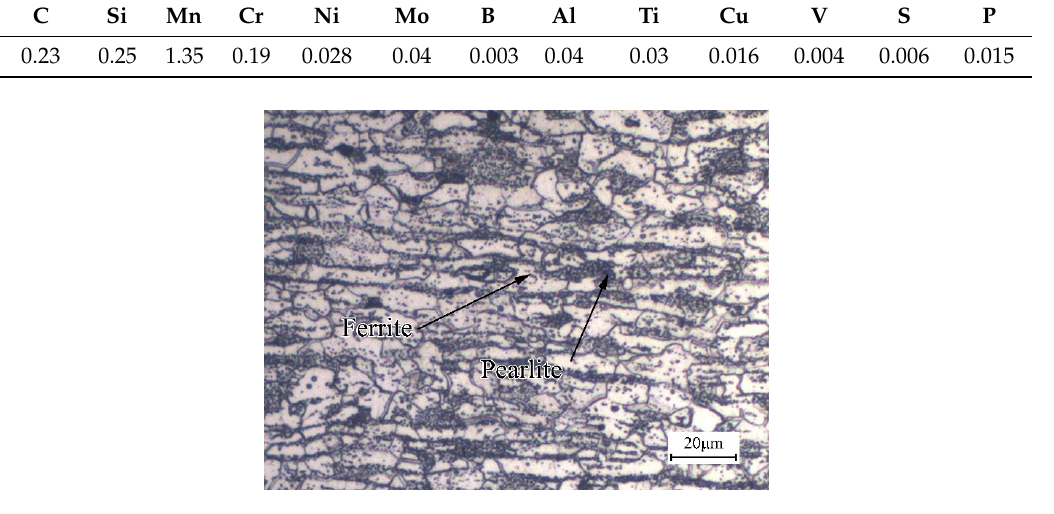
Figure 1. Microstructure of B1500HS high-strength steel.